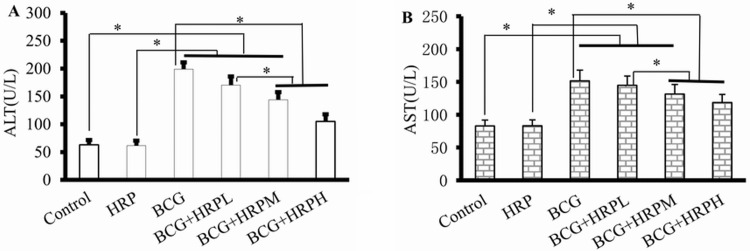
Effects of HRP on serum alanine aminotransferase (ALT, A) and aspartate aminotransferase (AST, B) in Bacillus Calmette-Guérin (BCG)-induced hepatic injury in rats in vivo. Data are presented as means ± SD of n = 10 rats. Asterisks stars above bars indicate differences between groups.